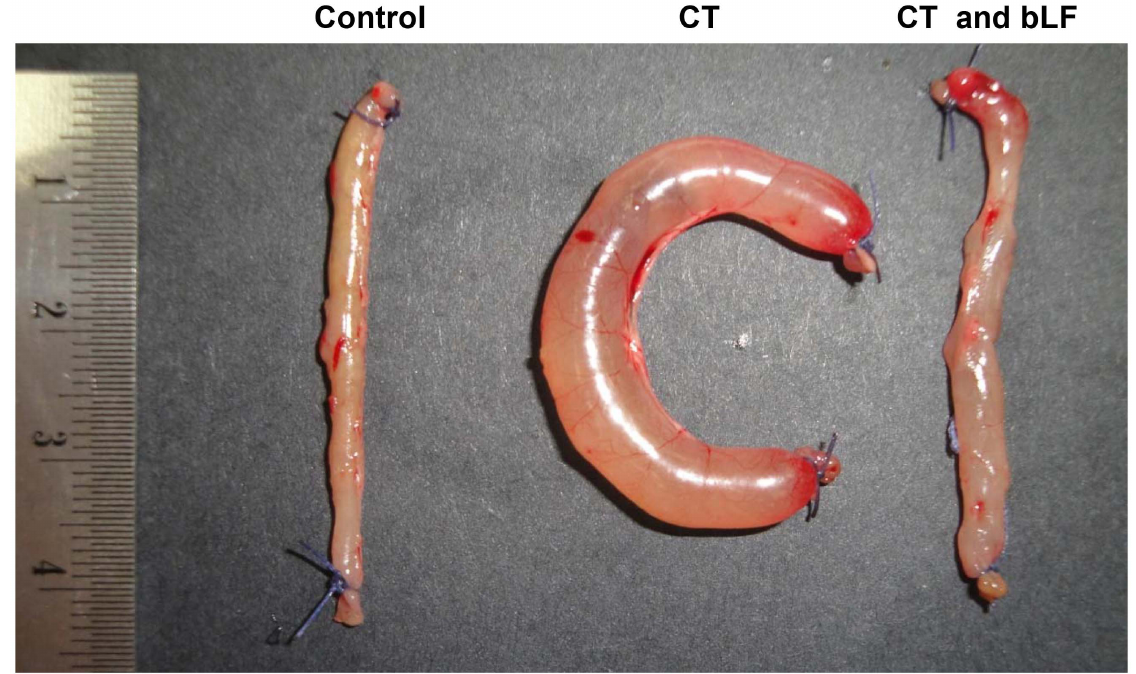
Figure 4. Inhibitory effect of bovine lactoferrin (bLF) on CT-induced fluid accumulation in the mouse ileal loop. Control (phosphate- buffered saline, pH7.4) or CT (1.5 m g) without or with bLF (10 mg/mL) were simultaneously injected into the ileal loops, and mice were sacrificed 24 h later.